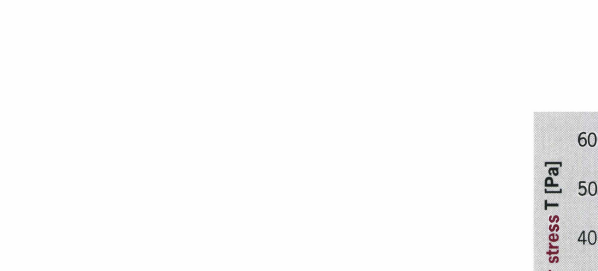
Fig. 1: Typical dependence of the shear stress on time for materials undergoing structural